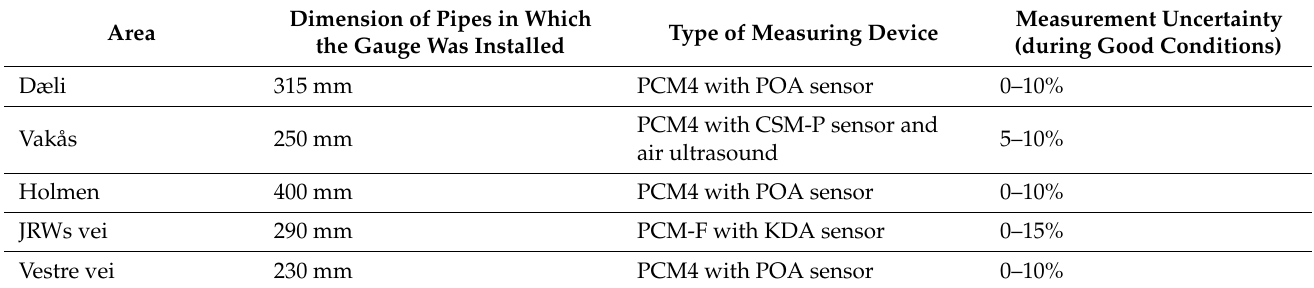
Table 1. Characteristics of the measuring devices used in the different zones.